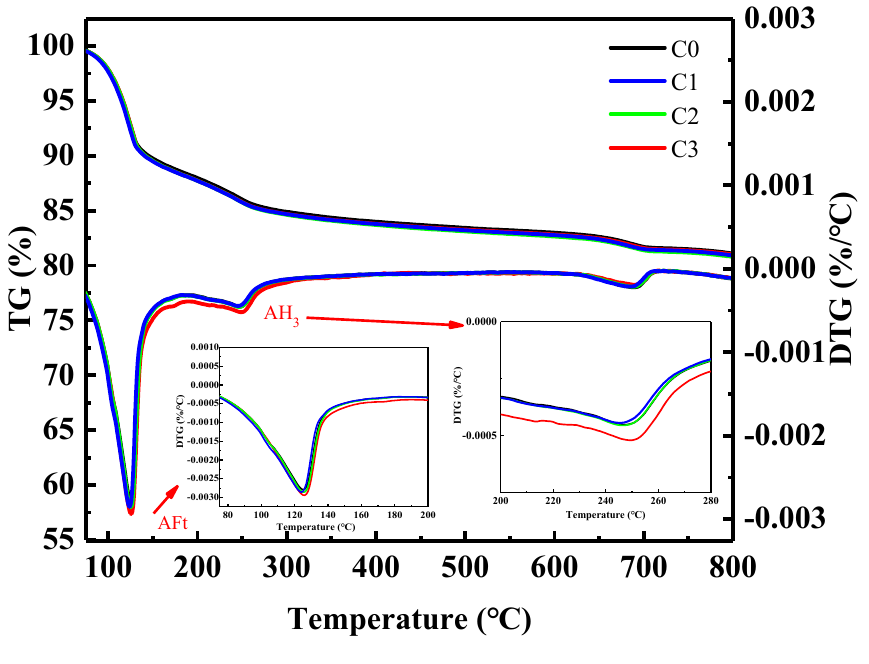
Figure 7. TG-DTG curves of SAC paste.